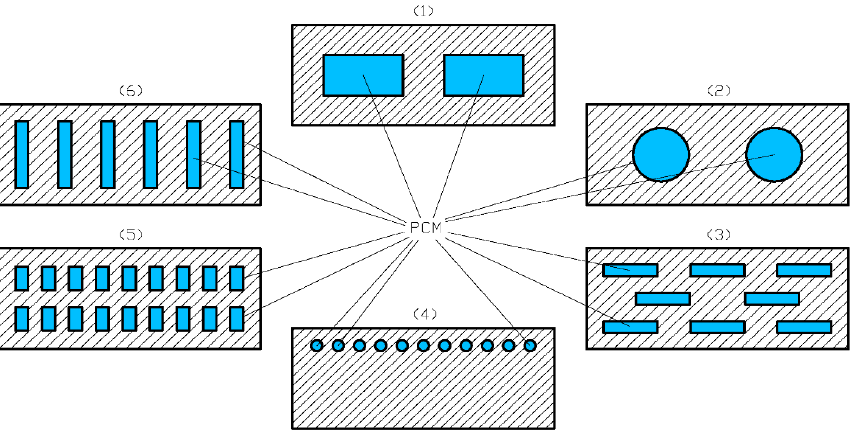
Figure 13. Standard shape of the hollow space (HS) to be filled with PCM. (1) Large rectangular HSs; (2) cylindrical HSs; (3) rectangular HSs aligned with the long axis; (4) small cylindrical HSs; (5) small rectangular HSs; (6) rectangular HSs aligned with the short axis.